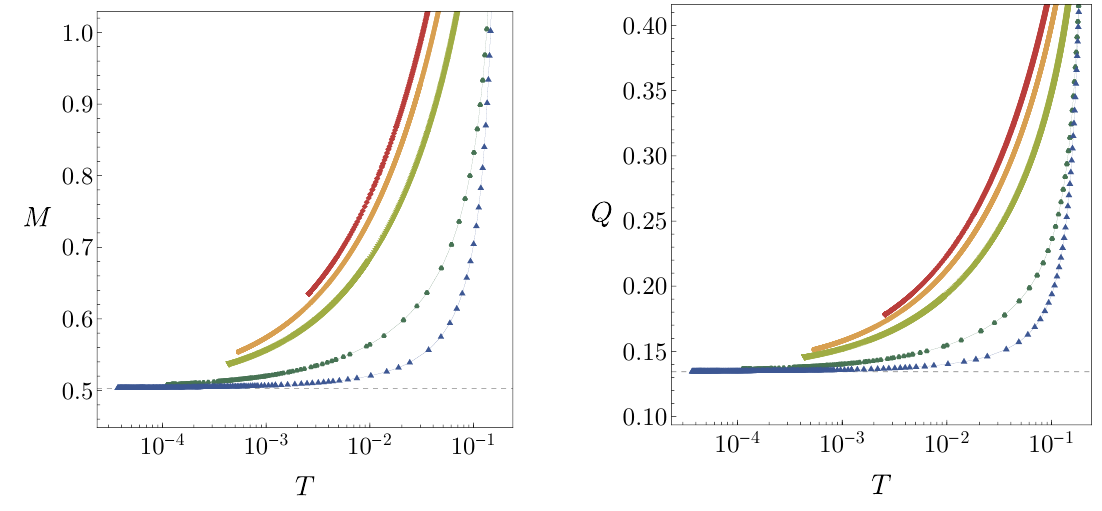
Figure 8 . Log-linear plot of the mass ( left ) and the charge ( right ) of the hairy solutions with angular momentum J = 0 : 05 versus T , for several values of " H . The horizontal dashed gridline shows the values for the supersymmetric black hole with the same J . The legend is the same as in (cid:12)gure 7.